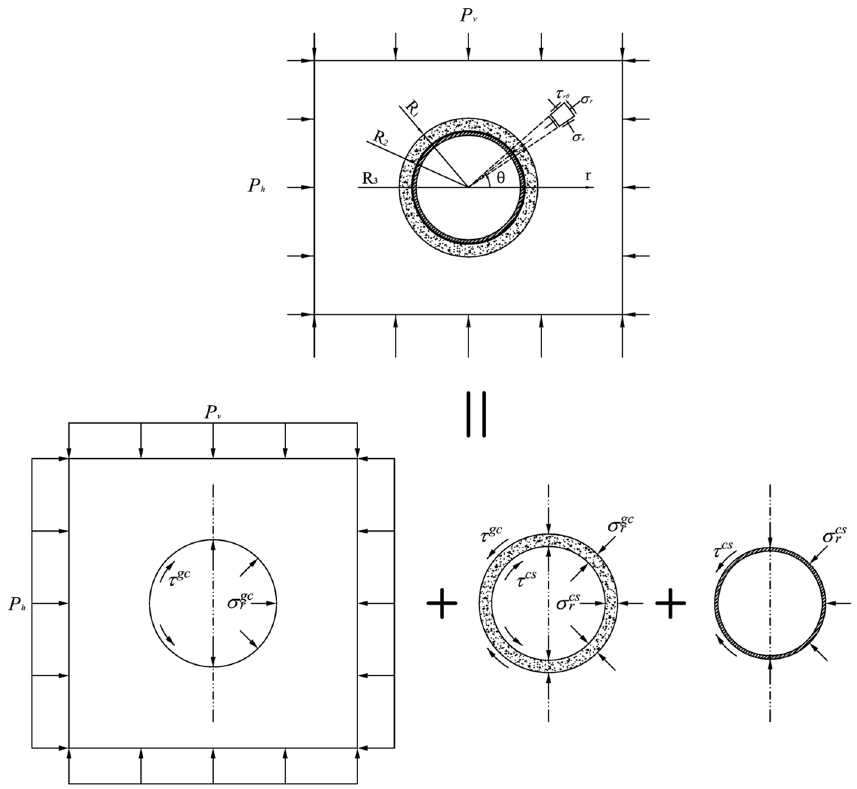
Figure 3. Decomposed model in terms of the ground, the concrete lining, and the steel plate.